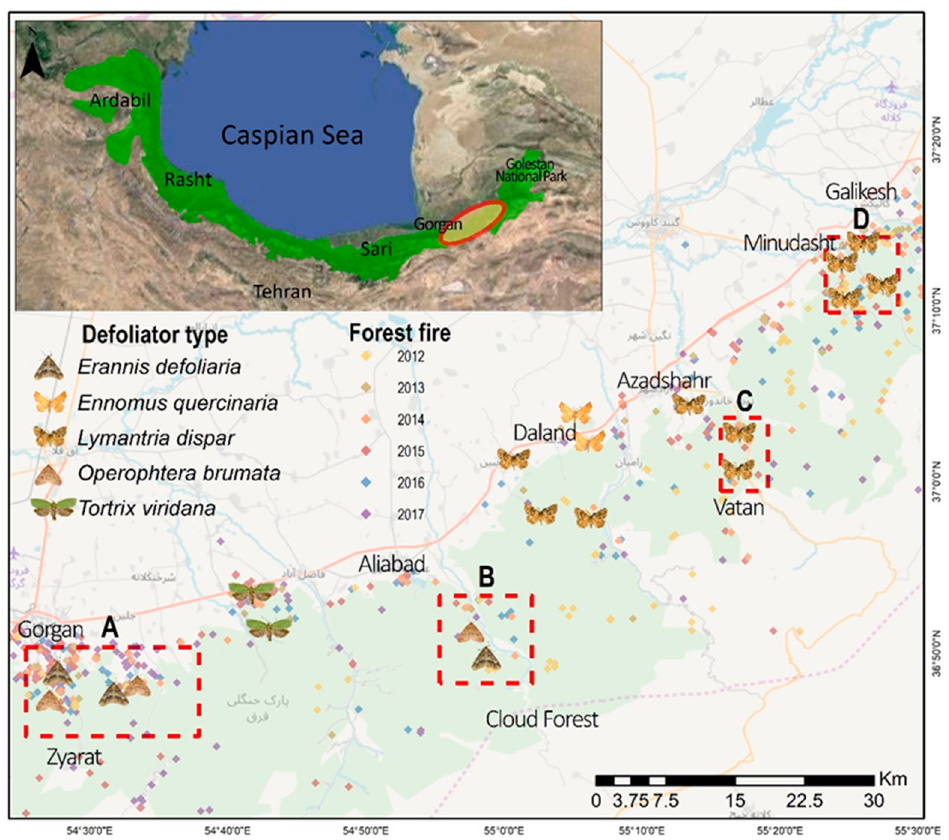
Figure 1. Study area in the Hyrcanian forest ecoregion in the southeast Caspian Sea. Spatial scatter of the insect defoliators and forest fires samples of 2012–2017 in northeast (NE) Iran. The eastern part of the study area was affected by Lymantria dispar , while the western area was affected by Erannis defoliaria and Operophtera brumata.